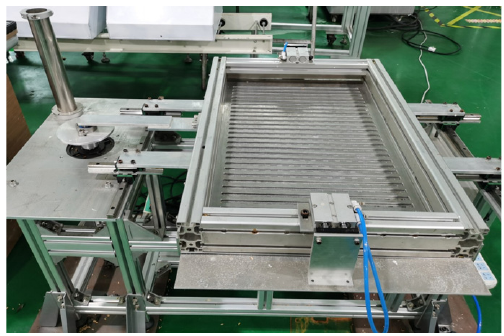
Figure 12. Model machine of horizontal rotary precision seed metering device.